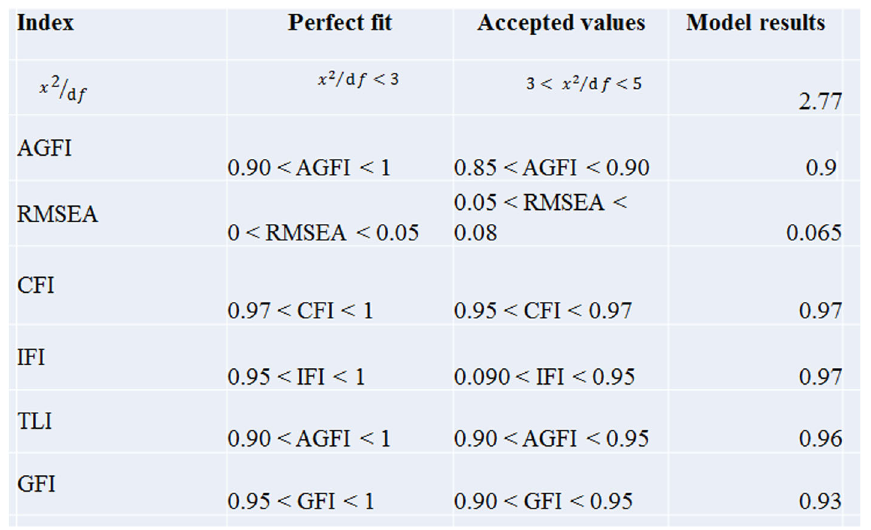
Table 3 Model fit indices for the measurement model